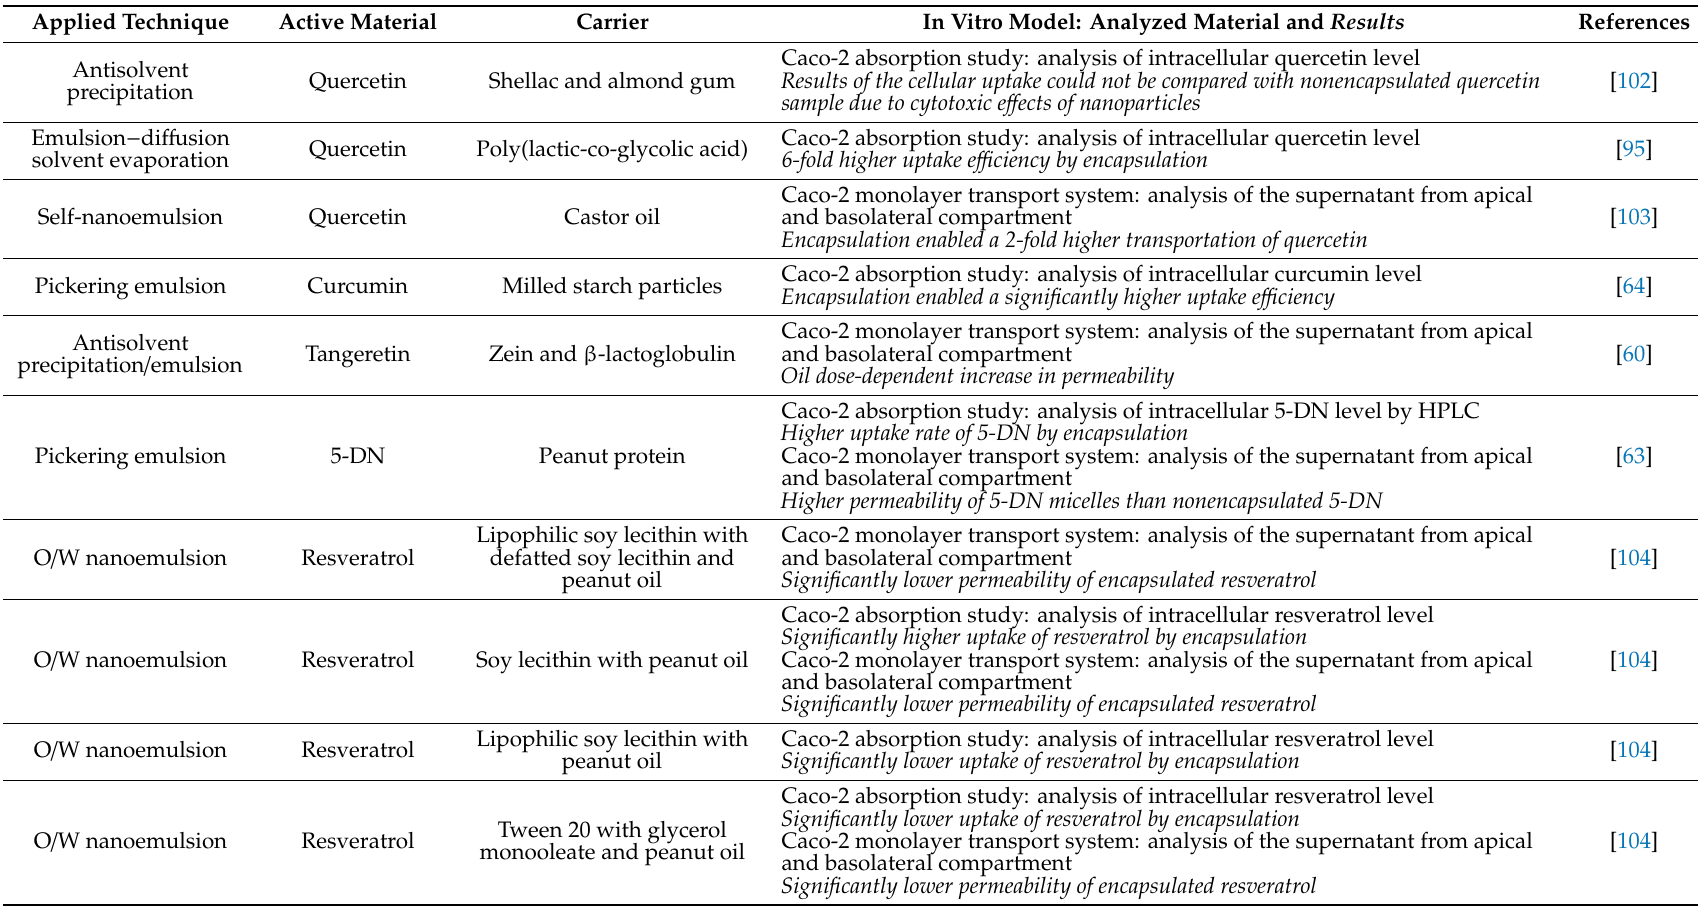
Table 2. E ff ects of lipid-based encapsulation techniques on the in vitro bioavailability of phenolic